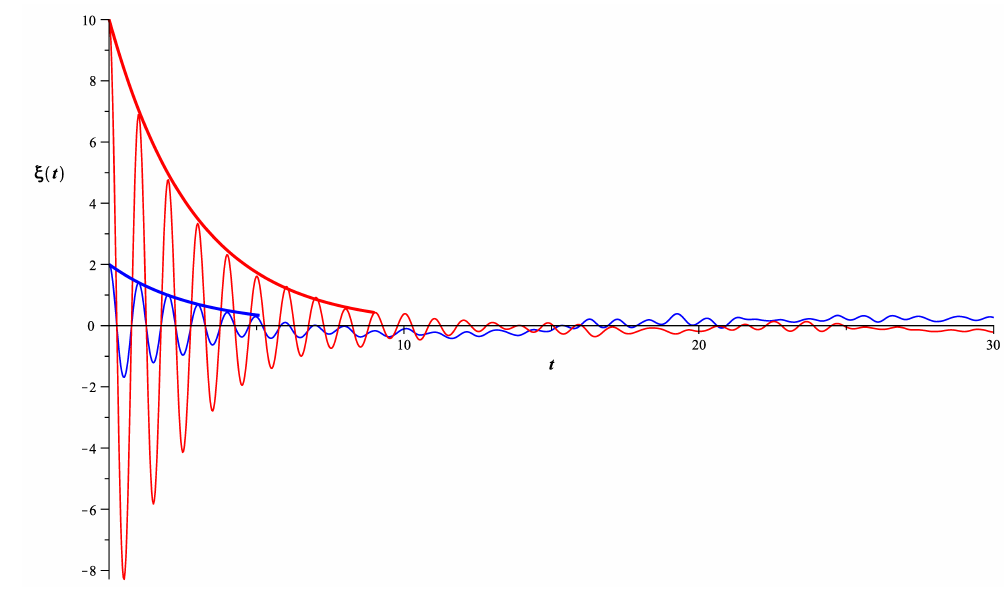
Figure 2. Evolution of impulsively excited oscillations described by a randomly driven harmonic oscillator with a linear damping term. The damping coefficient is δ = 0.7. The red and blue oscillatory curves correspond to different initial amplitudes. The thick curves show the exponential damping of the oscillation envelopes with the characteristic time 2/ δ